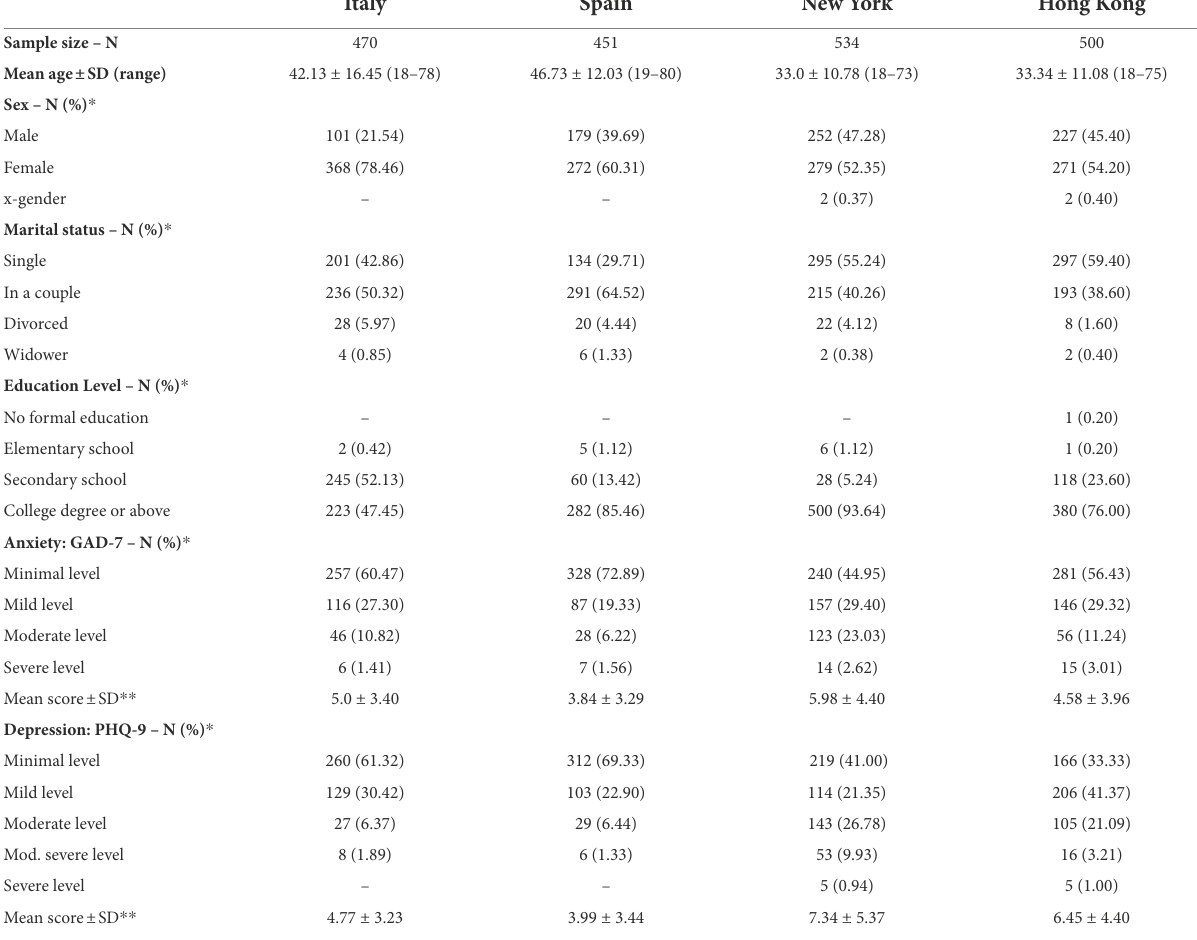
TABLE 1 Socio-demographic and clinical measures by